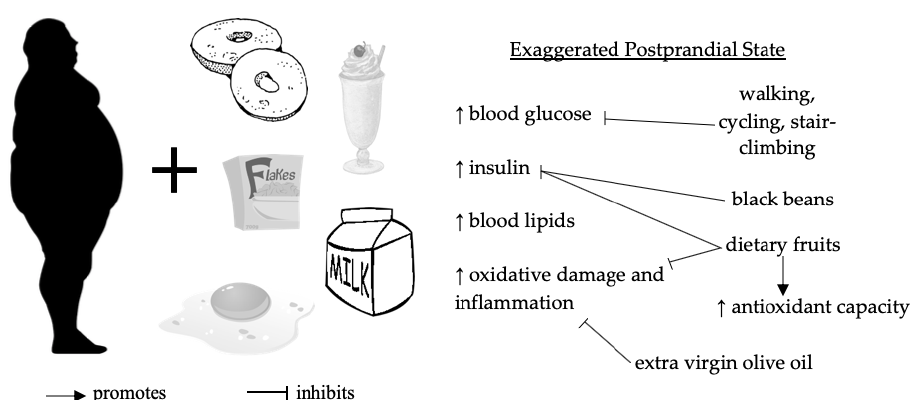
Figure 2. Effects of acute dietary polyphenol supplementation and post-meal physical activity on postprandial metabolism in adults with features of the metabolic syndrome (MetS).